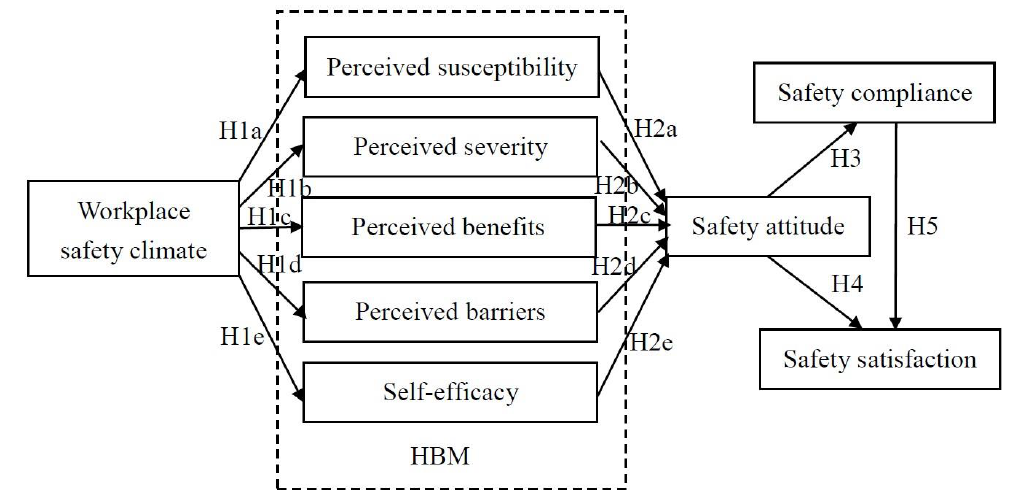
Figure 1. Research framework.